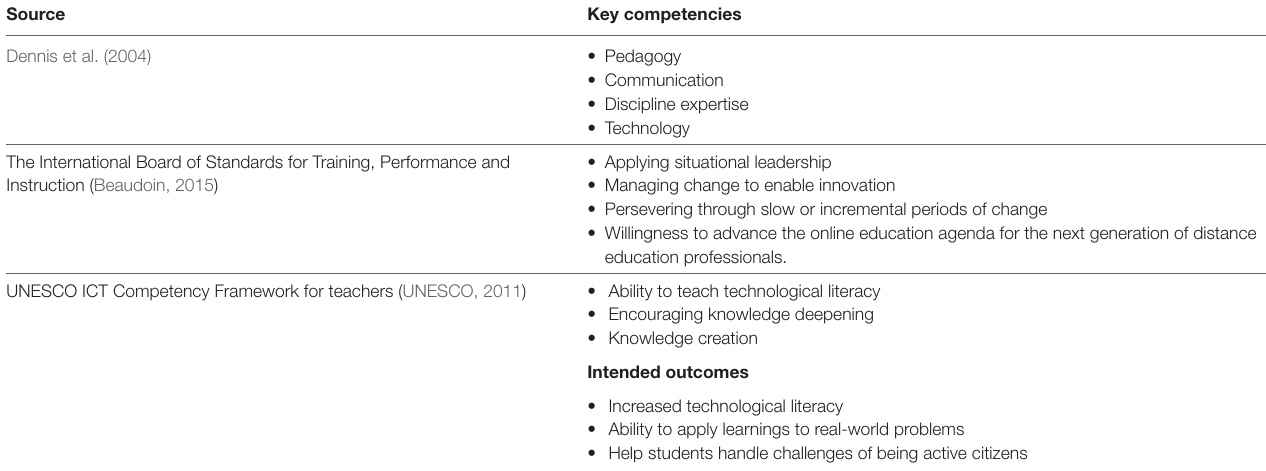
TABLe 1 | Established teacher competency frameworks in online education. Source Key